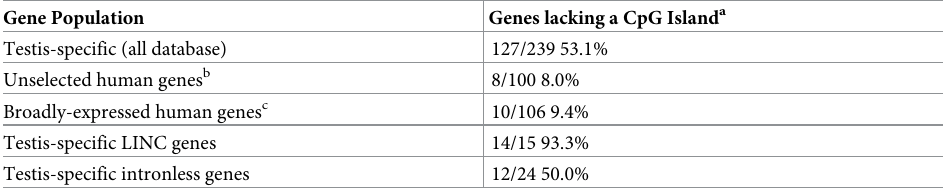
Table 1. Testis-specific genes lacking a CpG